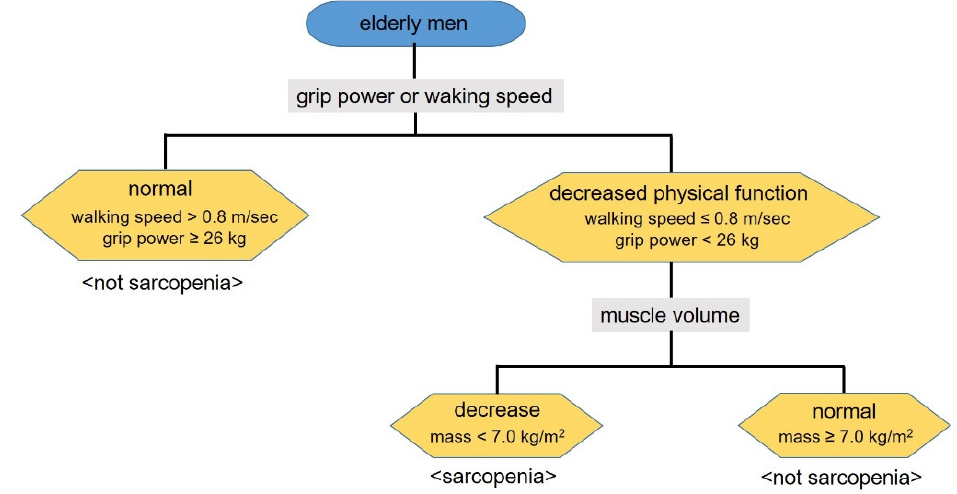
Figure 1. Algorithm for sarcopenia diagnosis (the Asian working group for sarcopenia). Table 1. Classification of sarcopenia by